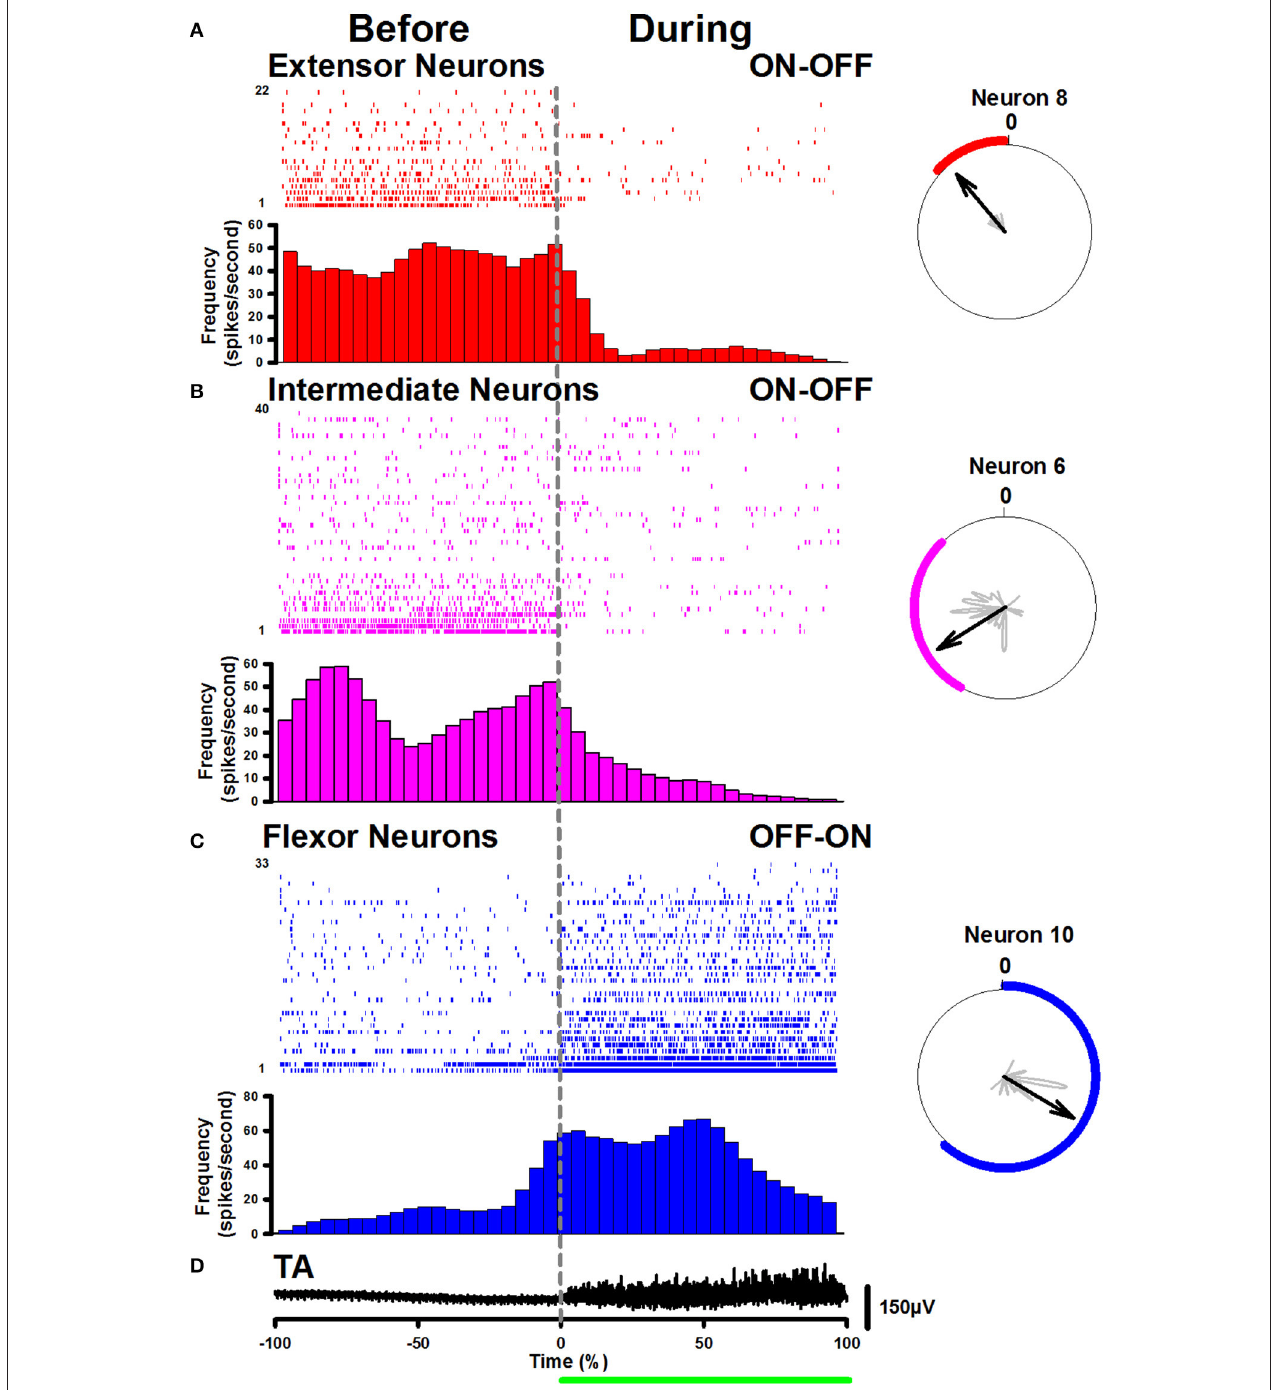
FIGURE 3 | Peri-event firing rates of spinal interneurons before and during the tonic flexor phase. (A) Raster display of 22 rhythmical neurons classified as extensor (red traces). (B) Raster display of 40 rhythmical neurons classified as intermediate (purple traces). (C) Raster display of 33 rhythmical neurons classified as flexor (blue traces). The beginning of the tonic flexor phase is indicated by the vertical dashed line (zero time as reference). (D) Electroneurogram of the tonic flexor phase of the TA nerve (black). The green horizontal line indicates the tonic flexor phase in the electrical activity of the TA nerve. The alternating rhythmical activity was excluded from the raster displays for simplicity. The corresponding histograms are illustrated below the raster plots. The histograms illustrate the mean instantaneous frequency as a function of time across the population of recorded neurons. The polar plots of some neurons are illustrated in the right panel. The polar plots show the phase of the interneuronal firing activity relative to the cycle of the TA